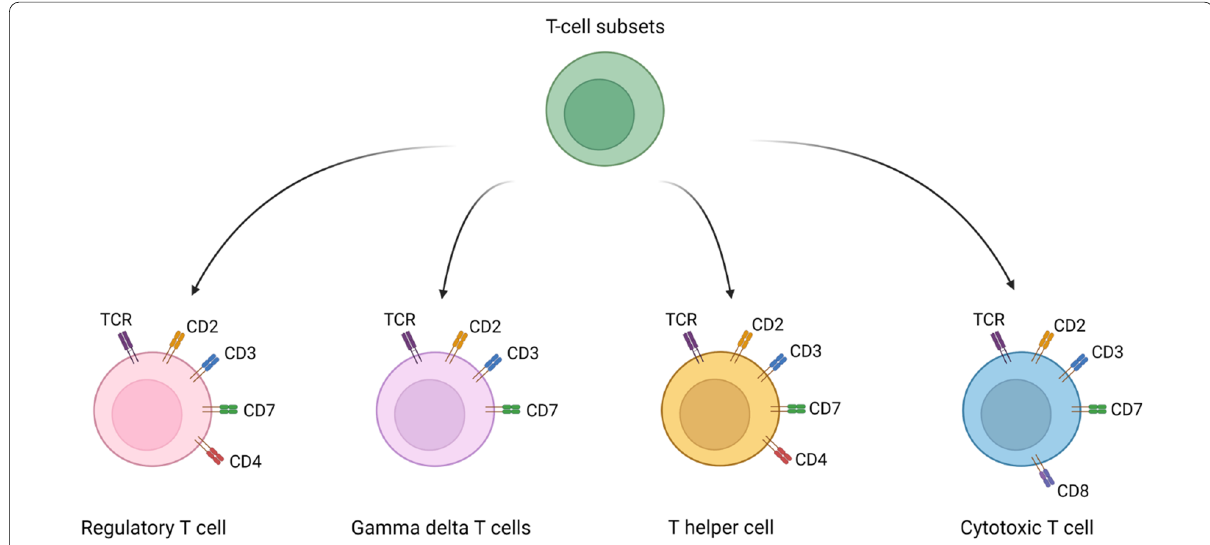
Fig. 3 Differentiation of T-cell subsets and their respective cell surface